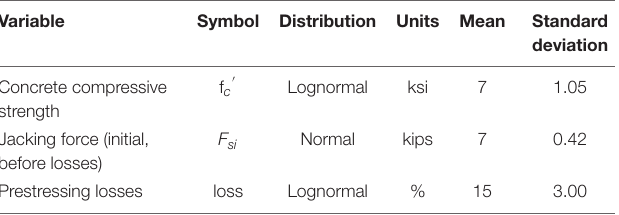
TABLE 3 | Random variables used in concrete sleeper flexural capacity